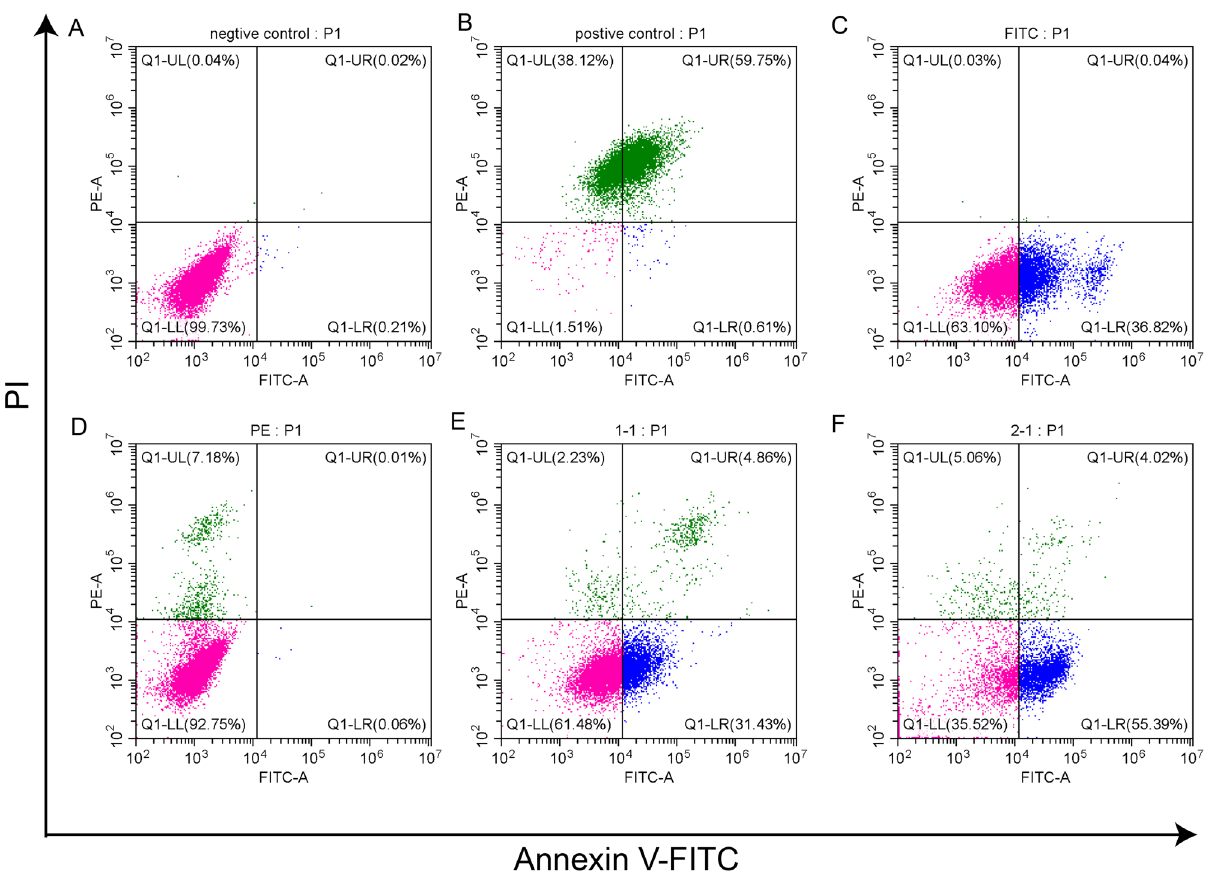
Figure 1. Apoptosis of cells cultured by two culture methods. ( A ) The gating strategy for flow cytometry analysis. ( B ) Apoptosis of cells treated with 4% paraformaldehyde (positive control). ( C ) Annexin V-FITC single staining control. ( D ) PI single staining control. ( E ) Apoptosis of cells in the natural growth state (Annexin V-FITC/PI double staining). ( F ) Apoptosis of cells in basket bioreactor culture (Annexin V-FITC/PI double